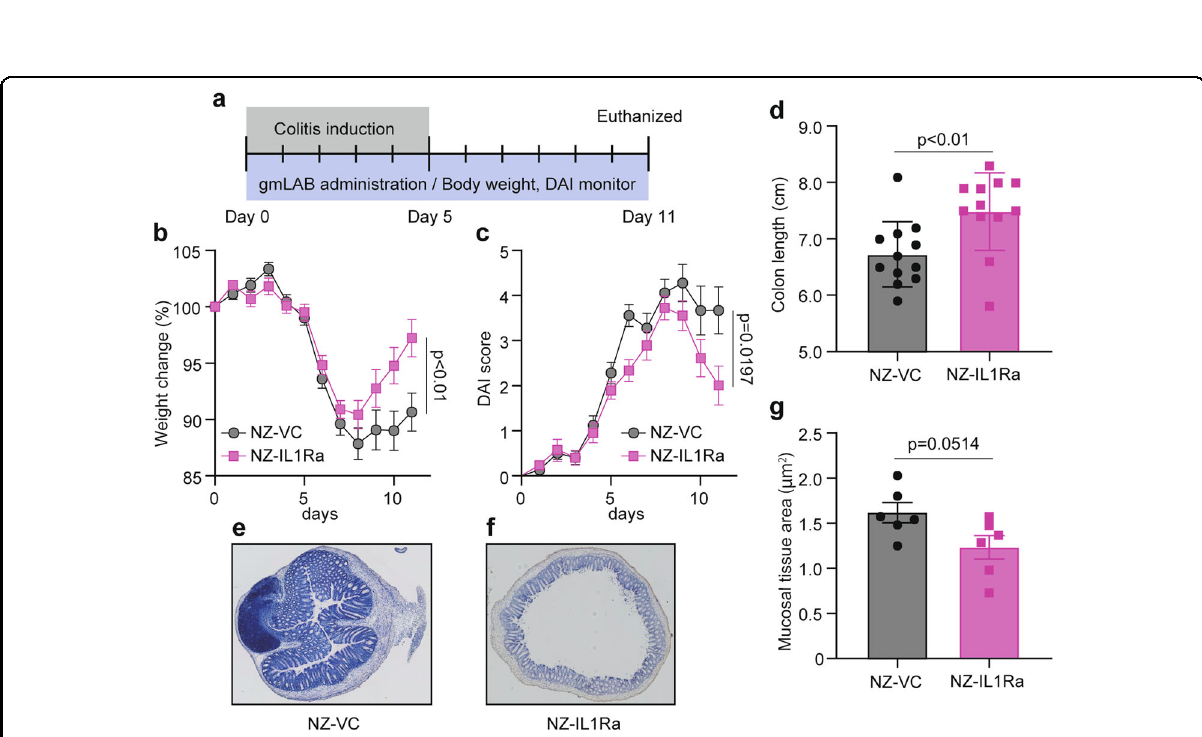
Fig. 5 Effect of oral administration of NZ-IL1Ra on DSS-induced colitis in model mice. a Schedule for colitis induction and oral administration. The in vivo experiment was repeated 3 times (total n = 18). b , c Change in body weight and DAI score, respectively, of mice with DSS-induced colitis. Data are the mean ± SE ( n = 18). The p values of day 11 results are shown. d Colon length on day 11. Data are the mean ± SE ( n = 12), and each dot in the plot represents one mouse. e , f Representative images of colon tissue stained with HE (10× magni fi cation). e NZ – VC, f NZ-IL1Ra. g Total mucosal area on day 11. Data are the mean ± SE ( n = 6), and each dot in the plot represents one